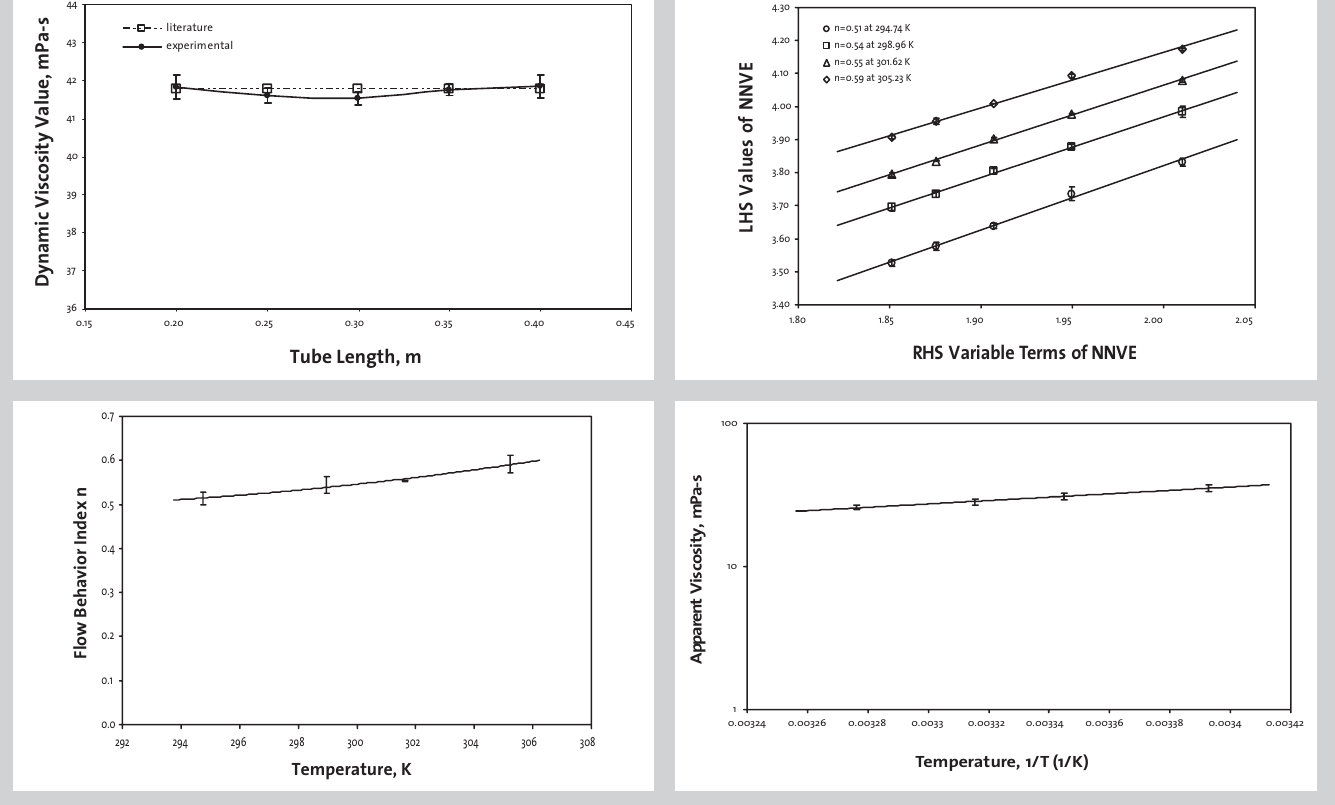
the 0.2 m drain tube, the 0.25 m drain tube, the 0.3 m drain tube, the 0.35 m drain tube, and the 0.4 m drain tube are shown in comparison with the literature value 41.7 mPa·s, as shown in Tab. 2 and Fig. 6.